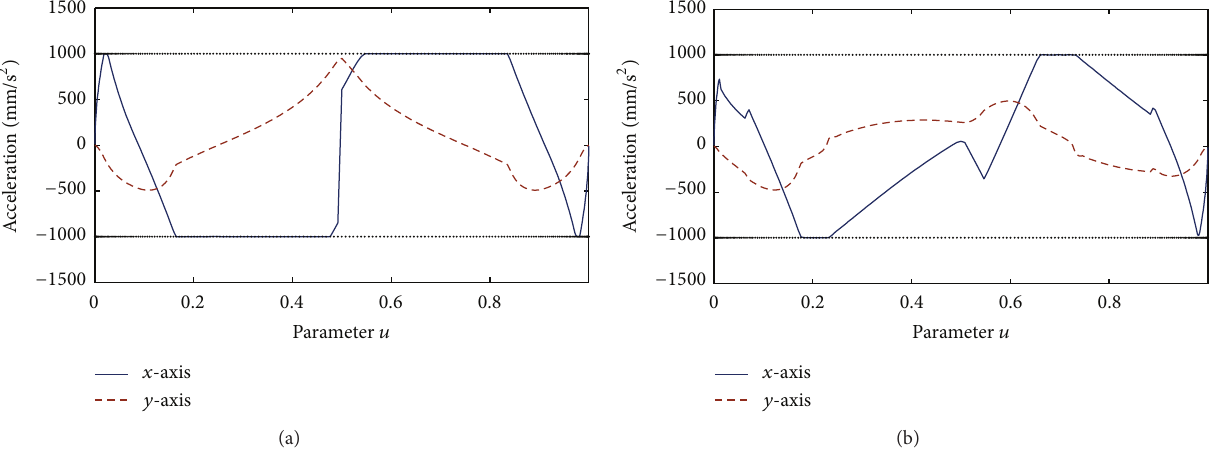
Figure 6: Acceleration trajectories of the (a) SMTT and (b) TEC-SMTT.